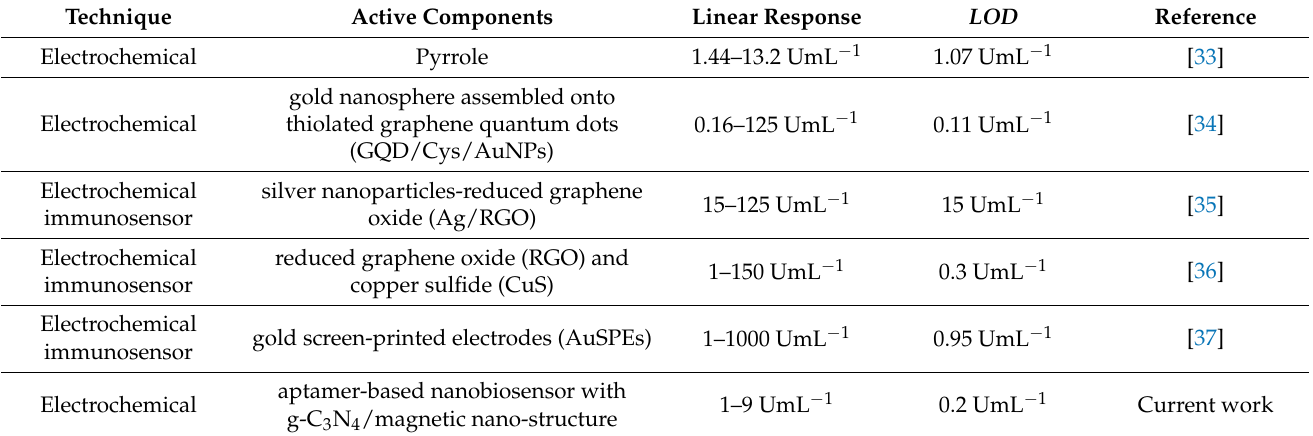
Table 1. Comparison of the provided biosensor with other studies for CA 15.3